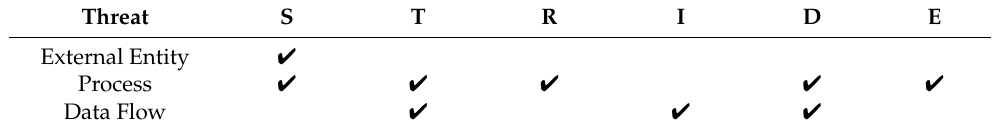
Table 6. Threats available in DFD components based on tree and mesh structures.